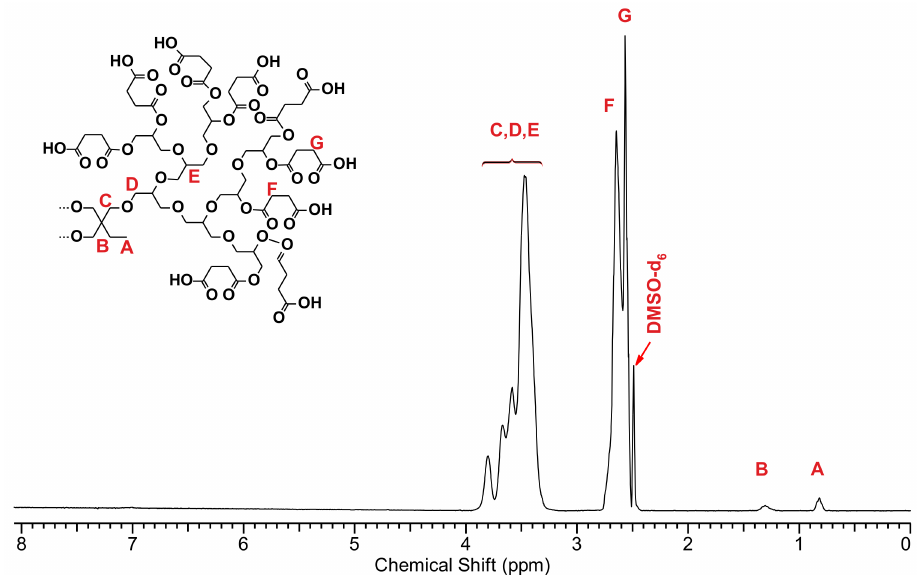
Figure 4. 1 H-NMR spectrum and schematic architecture of carboxy-functionalized polyglycerol. For Boltorn H40, the integral intensities of the signals corresponding to methylene groups of the polymer and succinic acid were compared (Figure 5). For both polyglycerol and Boltorn H40 polymers, the degree of the terminal hydroxyl group substitution was found to be 99.4–99.7%. This fact, together with the disappearance of the signals of terminal OH groups, allowed us to conclude that the hydroxyl groups of the polymers were practically completely